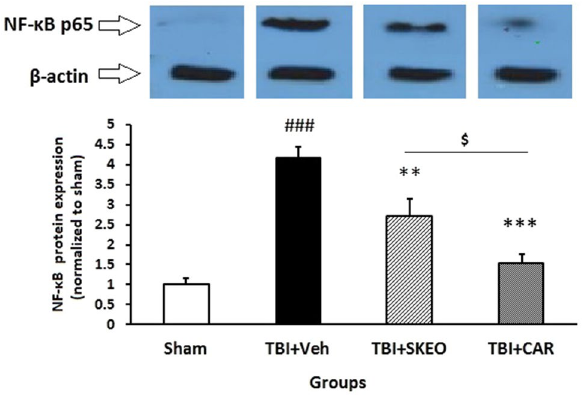
Figure 5. Effects of SKEO and CAR on the inflammatory protein NF-κB p65 expression 24 h after TBI induction in the different experimental groups (n = 6 rats per group). Cropped representative bands from the western blot test from the same run are shown above. Data are expressed as mean ± SEM band density ratio for each group. β-actin was used as an internal control. ### P < 0.001 represents a significant difference with sham; ** P < 0.05 and *** P < 0.01 represent significant differences with TBI + Veh. TBI: Traumatic brain injury; SKEO: Satureja khuzistanica essential oil; CAR: Carvacrol.